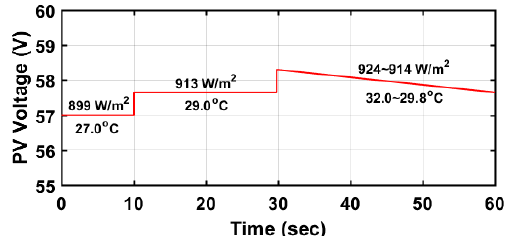
ff erent atmospheric conditions. Energies 2020 , 13 , x FOR PEER REVIEW